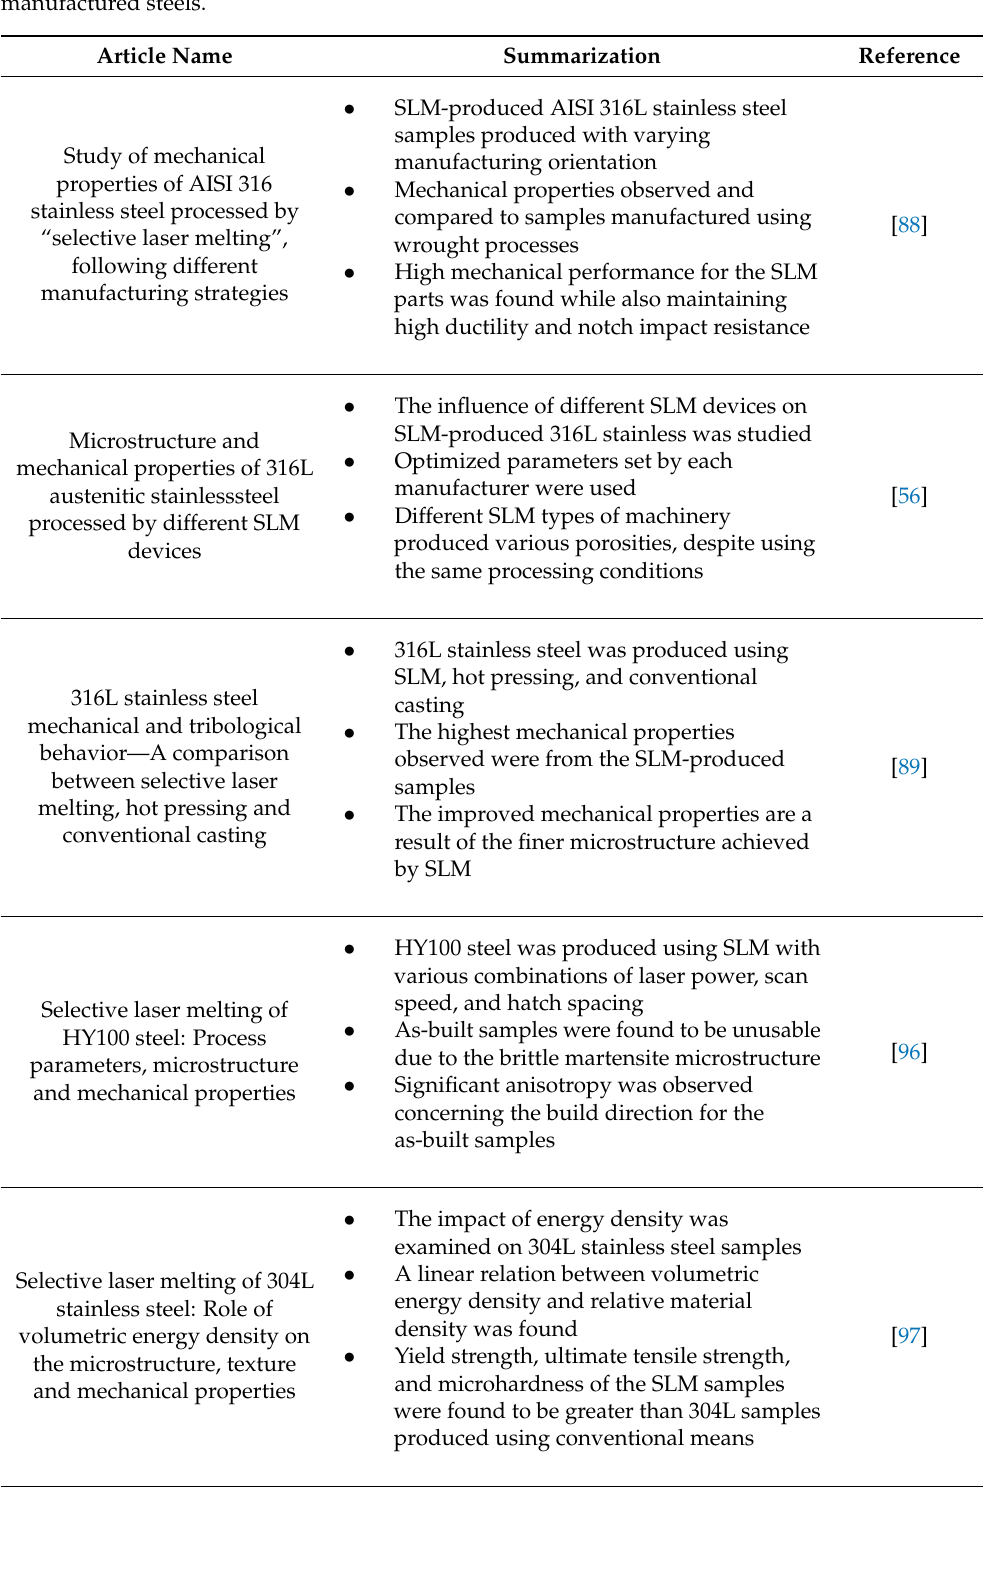
Table 2. Various publications summarize SLMs effects on the mechanical properties of SLM- manufactured